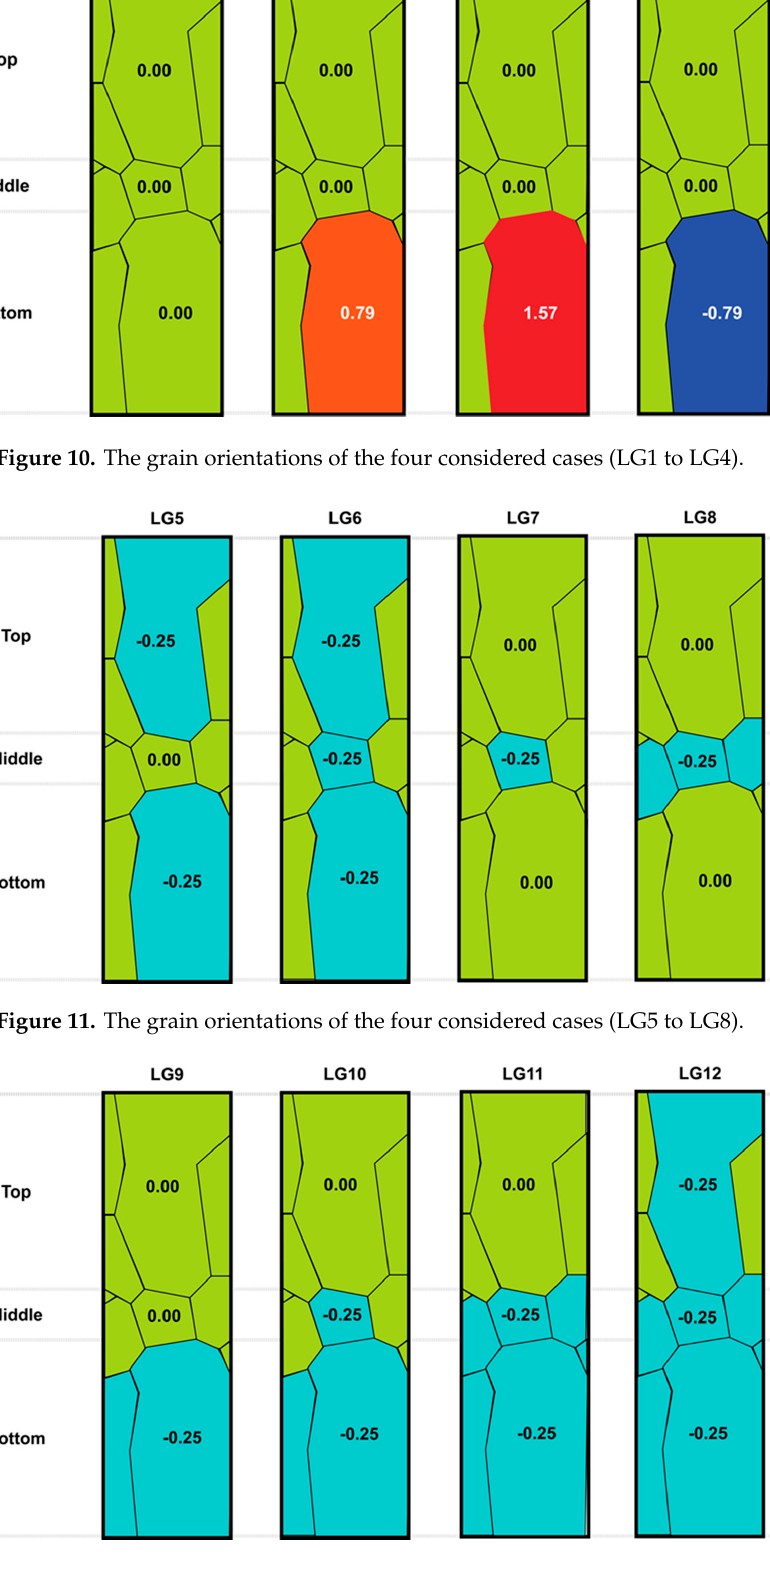
Figure 13. The grain boundaries of the four considered cases (small to large grain sizes) having the same grain orientation.